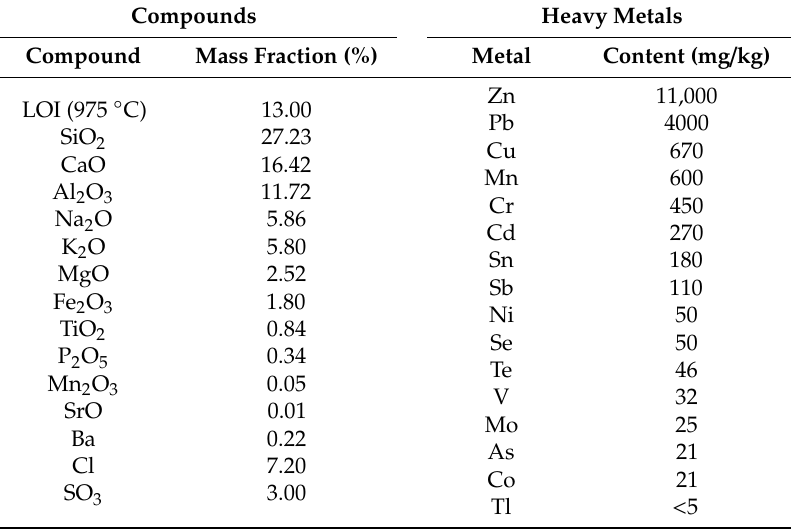
Figure 3. MSWI ashes: ( a ) BA; ( b ) FA. Table 1. Example chemical composition of MSWI FA